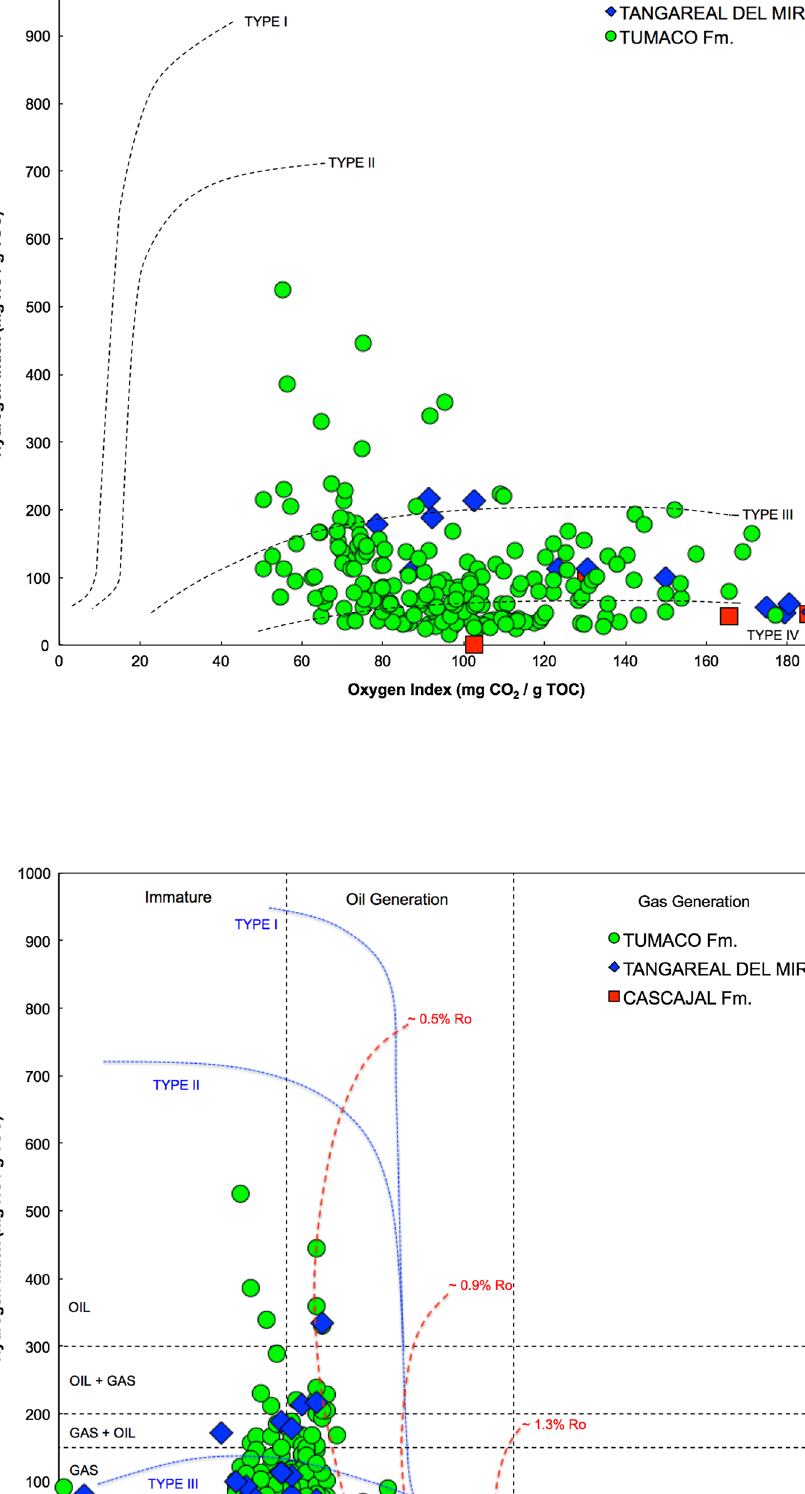
Fig. 3 Modified van Krevelen diagram based on IH versus IO for Tumaco-ST-P well, Tumaco basin, Colombia. HI = (S2/TOC) × 100, OI = (S3/ TOC) × 100